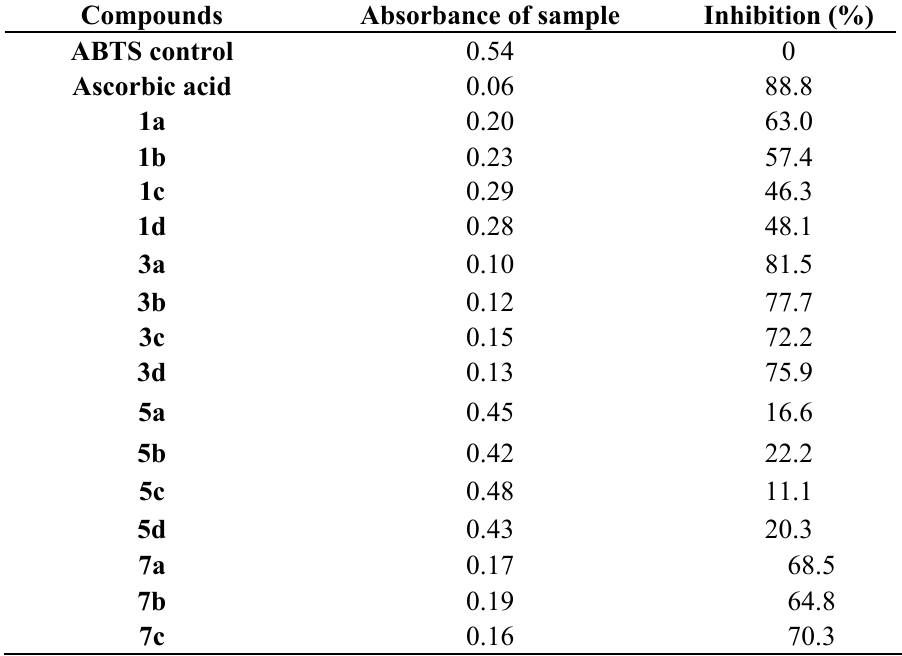
Table 3. Antioxidant assays by ABTS method [Abs. (control) − Abs.(test)/Abs.(control) ×